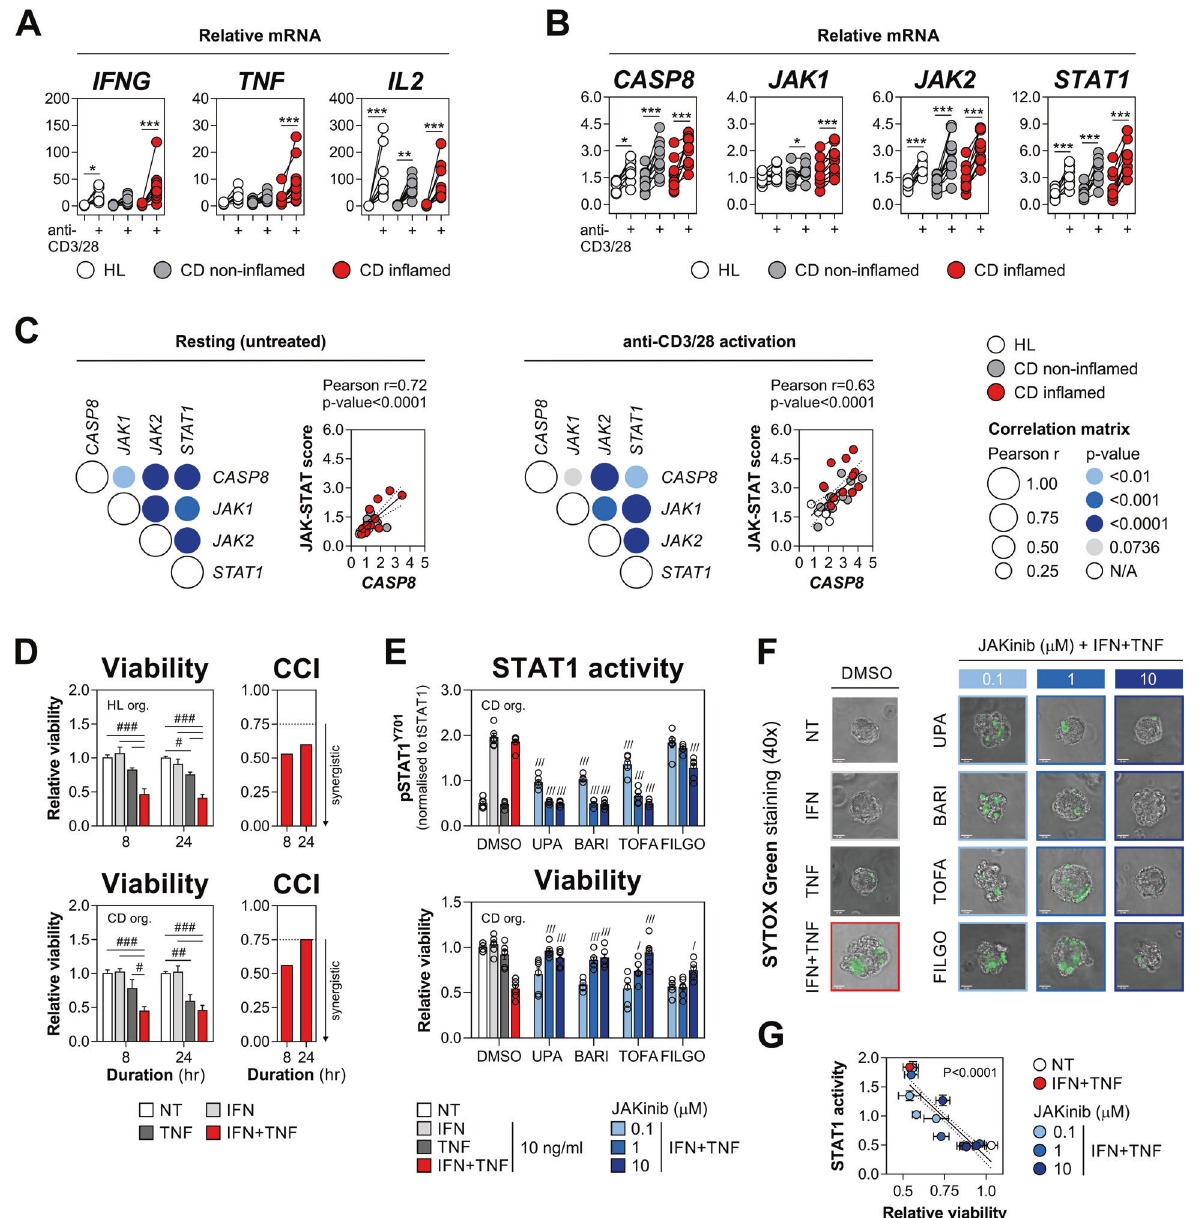
Fig. 7 Activation of the CASP8-JAK1/2-STAT1 cell death module in human colonic biopsies and organoids. A – C Colonic biopsies isolated from healthy (HL) individuals ( n = 10) or patients with inactive/non-in fl amed ( n = 11) and active/in fl amed ( n = 11) Crohn ’ s disease (CD) were incubated ex vivo with anti-CD3/28 (5 μ g/ml each) for 18 h. Relative mRNA expression of A IFNG, TNF and IL2 , and B JAK1 , JAK2 , STAT1 and CASP8 measured by RT-qPCR. C Correlation between relative mRNA levels of the indicated genes or the JAK-STAT score in resting (left) and anti-CD3/28- stimulated biopsies (right). D Relative viability of primary human colonic organoids derived from HL ( n = 3 lines) or CD ( n = 3 lines) colonic biopsies, and stimulated with IFN- γ and/or TNF- α (10 ng/ml each) for the indicated times. Coef fi cient of cytokine interaction (CCI) calculated per time-point (right). E – G Primary human colonic organoids derived from CD colonic biopsies ( n = 3 lines) were pretreated for 1 h with vehicle (DMSO), JAK1-selective compound (upadacitinib and fi lgotinib), JAK1/2 inhibitor (baricitinib) or pan-JAK inhibitor (tofacitinib) at 0.1, 1 or 10 μ M, followed by IFN- γ and/or TNF- α (10 ng/ml each) for the indicated times. E STAT1 activity was measured by HTRF assay at 2 h (top) and relative viability at 8 h (bottom) of cytokine treatment. F SYTOX Green staining of a select organoid line at 8 h of cytokine treatment. G Pearson correlation between relative viability and STAT1 activity. Data were mean ± SEM. * p < 0.05, ** p < 0.01 and *** p < 0.001 (two-way, repeated- measures ANOVA with Bonferroni ’ s multiple comparisons test), # p < 0.05, ## p < 0.01 and ### p < 0.001 (two-way ANOVA with Tukey ’ s multiple comparisons test), / p < 0.05, /// p < 0.001 (one-way ANOVA with Dunnett ’ s multiple comparisons test vs. DMSO plus IFN- γ /TNF- α ). NT non-treated, JAKinib JAK inhibitor, UPA upadacitinib, BARI baricitinib, TOFA tofacitinib, FILGO fi lgotinib, org. organoids, CCI coef fi cient of cytokine